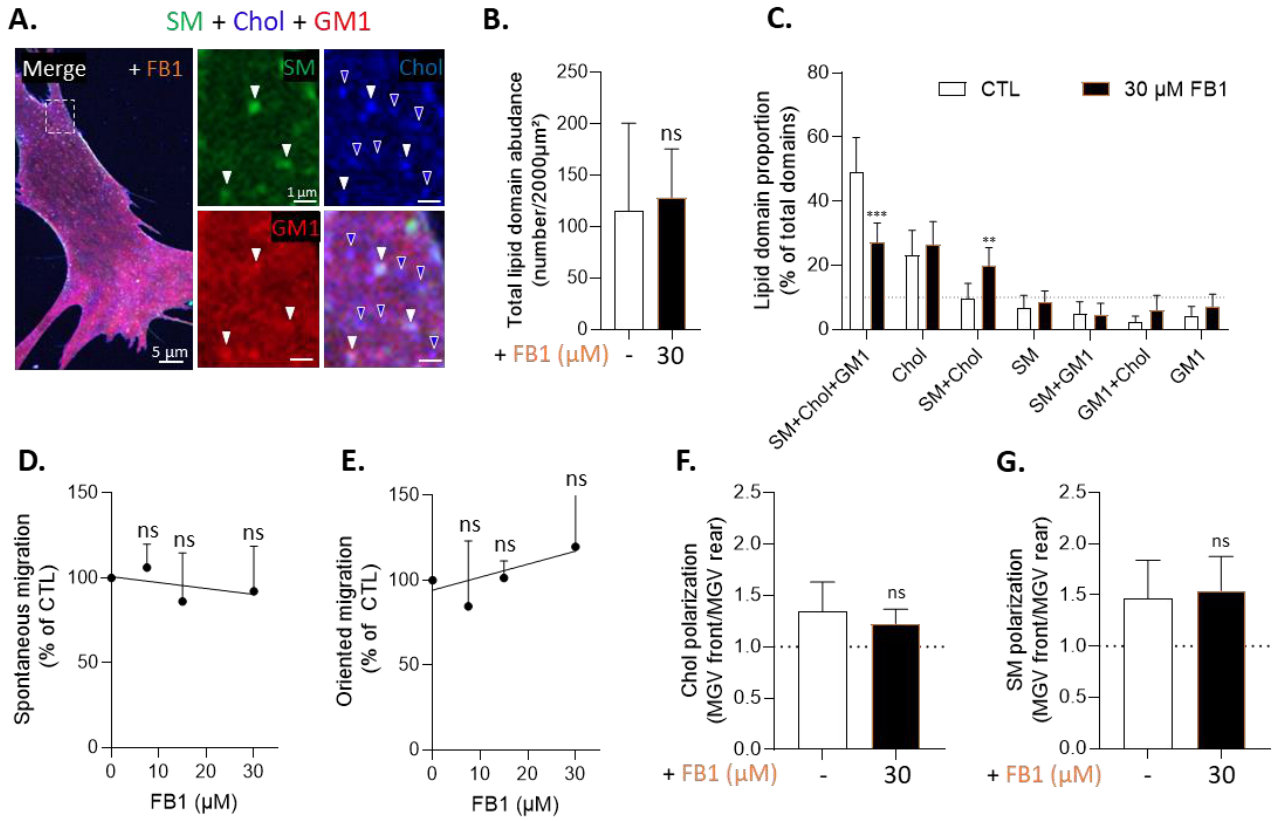
Figure 5. Sphingolipid synthesis inhibition by fumonisin B1 decreases the proportion of SM/chol/GM1- but not of chol-enriched domains and does not decrease myoblast migration nor lipid polarization. ( A – C ) Cells were pretreated or not with FB1 then triple-labeled (BODIPY-SM, theta, CTxB; ( A ) and quantified for lipid domain abundance relative to the cell surface ( B ) and lipid domain proportion ( C ), as in Figure 2. White arrowheads indicate the SM/chol/GM1-enriched domains; blue arrowheads indicate the chol-enriched domains. Dotted line indicates the threshold for lipid domain acknowledgement. The data are expressed as mean ± SD ( n = 10 cells for each condition from 2 independent experiments; 10–15 profiles drawn and 150–200 domains analyzed/cell). Wilcoxon signed-ranked test and two-way ANOVA followed by Sidak’s multiple comparisons test. ( D , E ) The quantification of myoblast spontaneous ( D ) or oriented ( E ) migration in Ibidi chambers or transwells towards IGF-1 after FB1 treatment. The data are expressed as mean ± SD ( n = 5–10 independent experiments). Kruskal–Wallis test followed by Dunn’s multiple comparisons test. ( F , G ) The quantifi- cation on single-labeled cells of chol (theta, F ) and SM (lysenin, G ) polarization after 5 h of migration in control conditions or after pretreatment with FB1. The data are expressed as the ratio of the MGV at the front vs. the MGV at the rear ( n = 8–16 cells from 1–2 independent experiments). Dot- ted line indicates no polarization. Unpaired t -test. The statistics above the columns refer to the corresponding